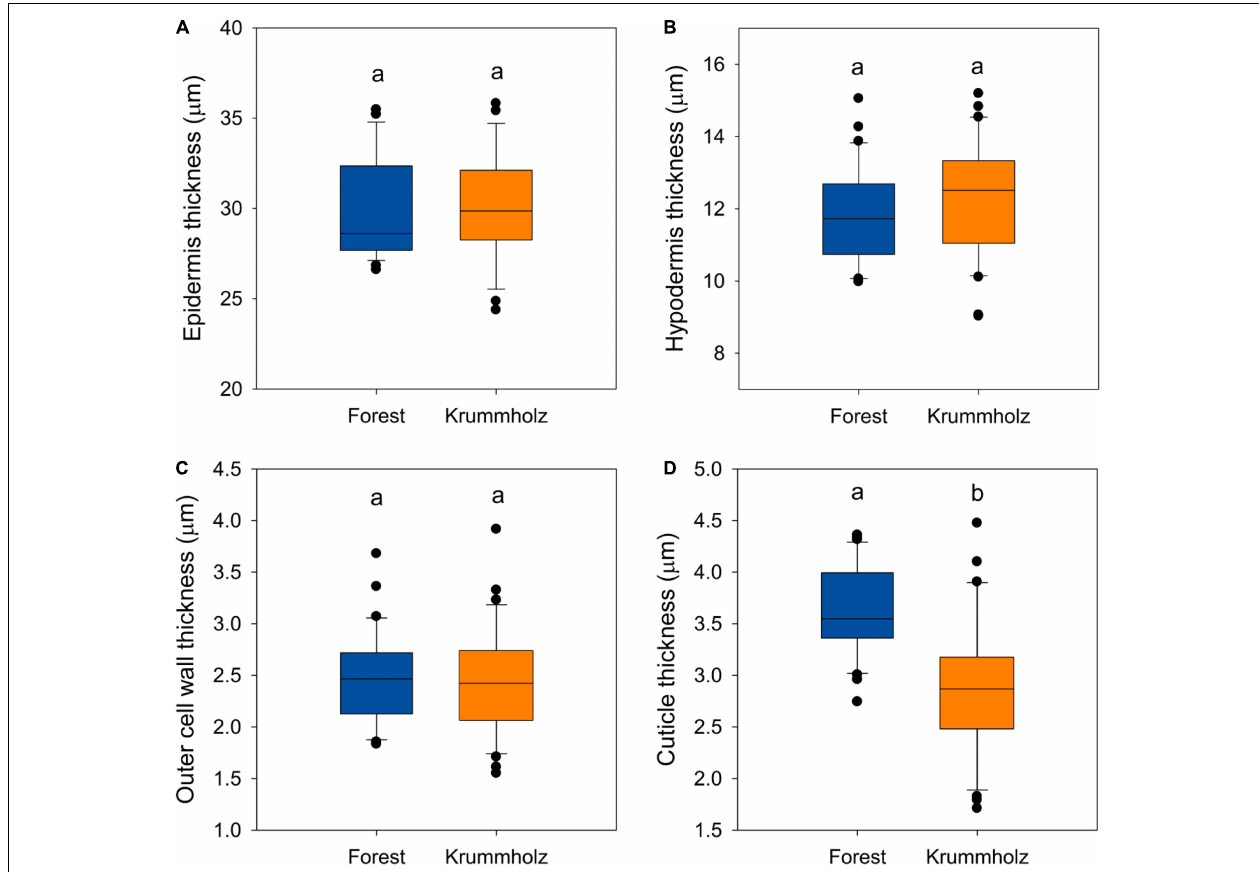
FIGURE 5 | The thickness of the (A) epidermis, (B) the hypodermis, (C) the outer cell wall of the epidermis, and (D) the cuticle for needles of P. uncinata grown at Forest and Krummholz populations. Different letters indicate statistically significant differences ( p < 0.05) between both populations.